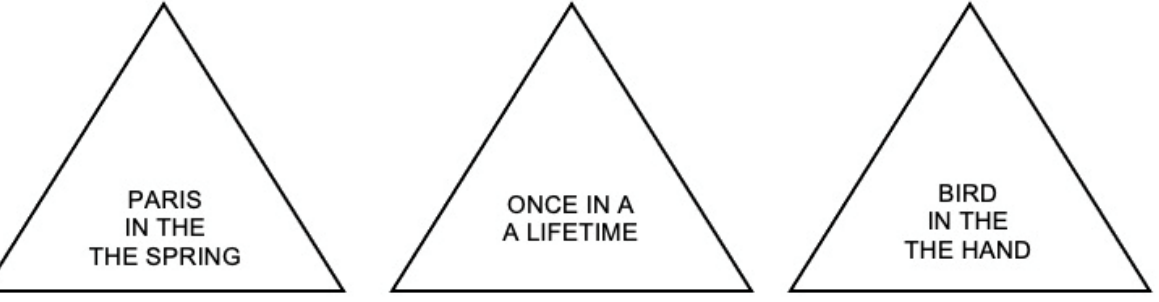
Figure 3. Perceiving Data.